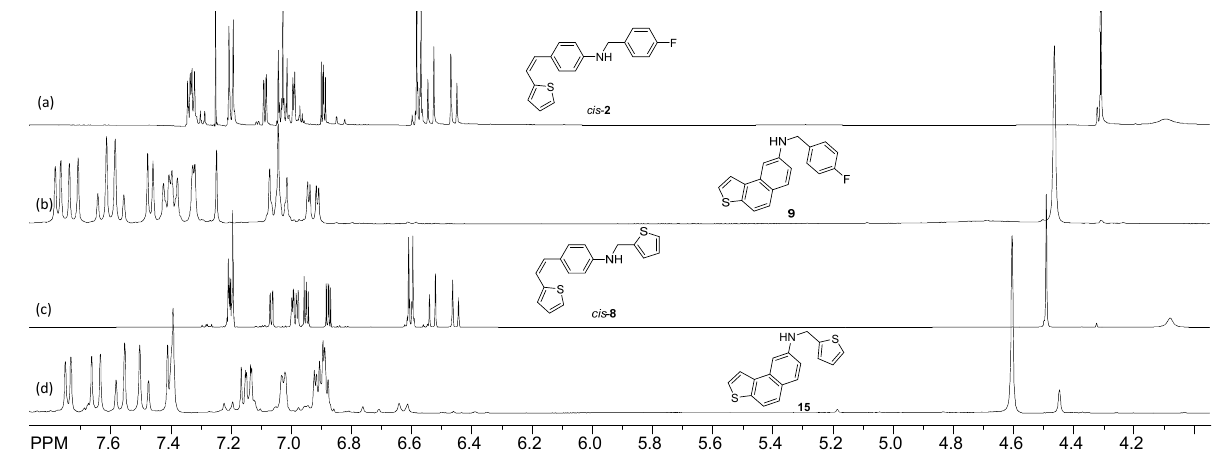
Figure 5. Selected 1 H NMR spectra (CDCl 3 ) of cis - 2 ( a ) and cis - 8 ( c ) and their photocyclization products 9 ( b ) and 15 ( d ), respectively.